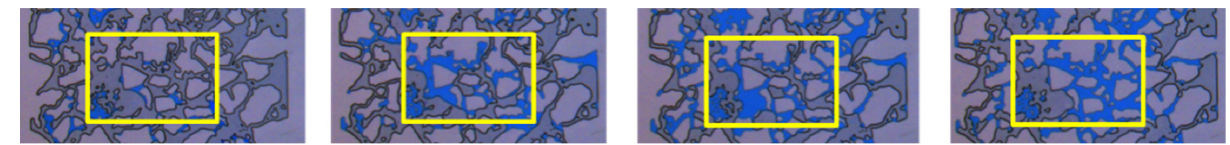
Figure 11. The comparison of retained water in selected areas, 200 μ m.